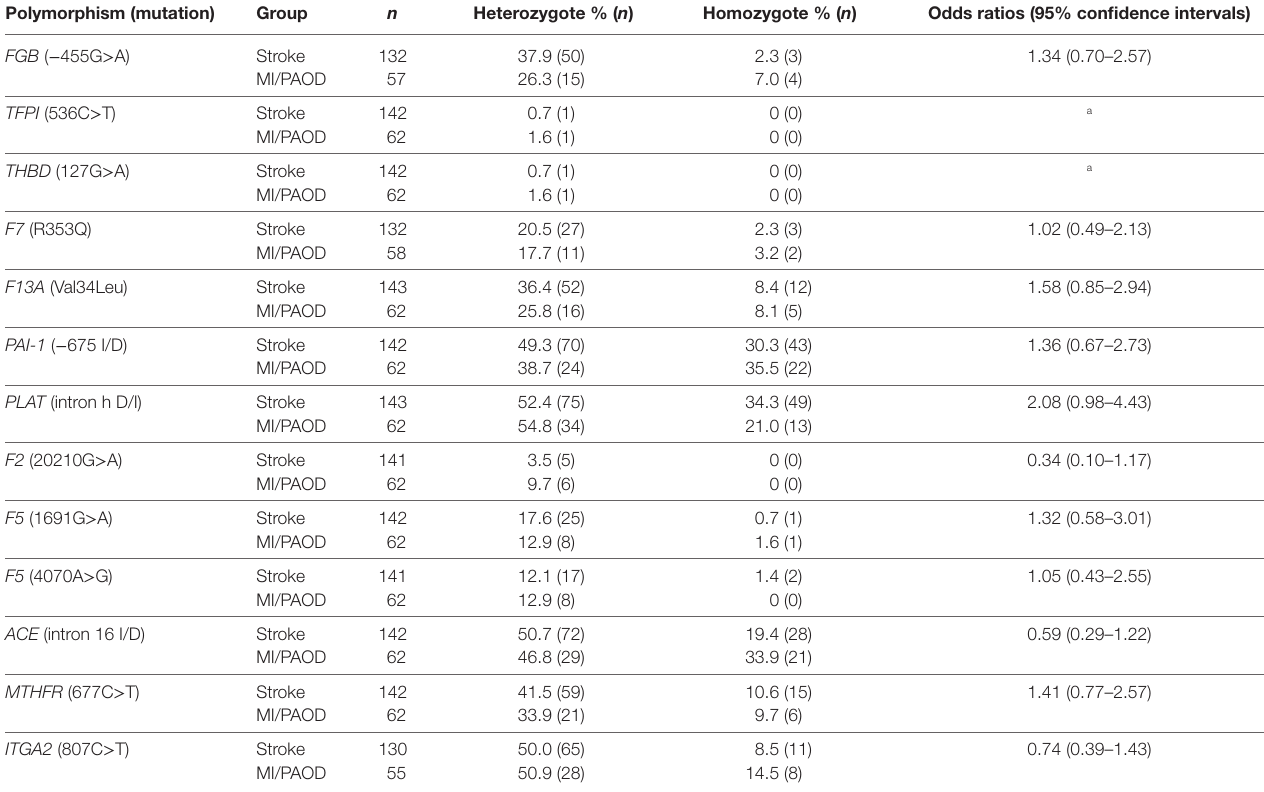
TaBle 3 | Prevalence of gene polymorphisms in ischemic stroke patients ( n = 144), patients with myocardial infarction (MI) or peripheral arterial occlusive disease (PAOD) ( n =